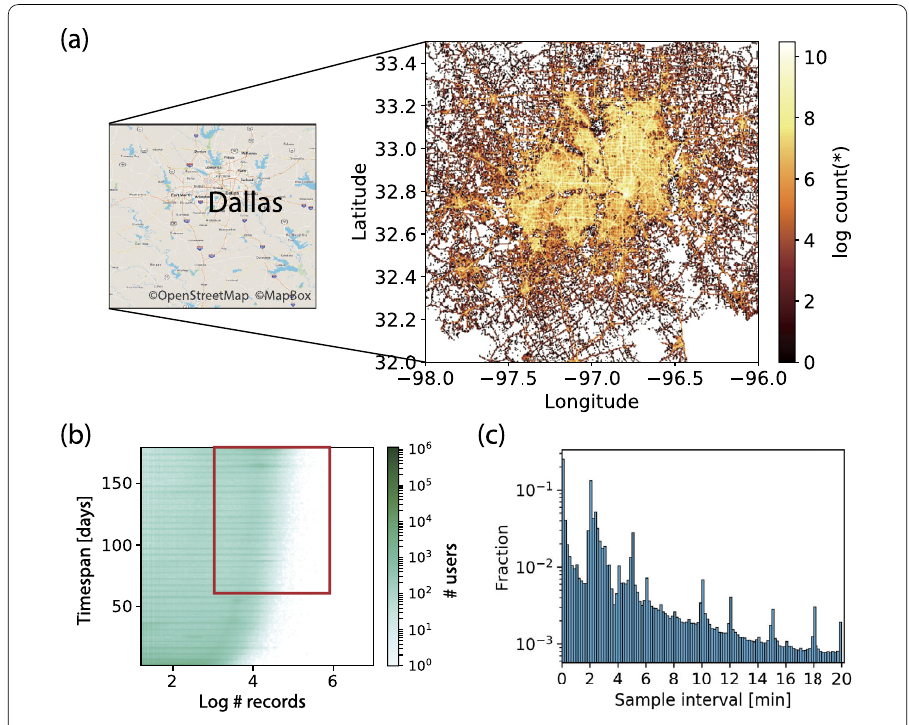
Figure 1 LBS data and user selection. ( a ) Spatial distribution of users’ traces in the LBS data, measured by the logarithm of the total visitation in each grid. ( b ) User timespan versus his/her number of records. Users outside the red rectangle are eliminated in further analysis. ( c ) Distribution of sample interval of LBS